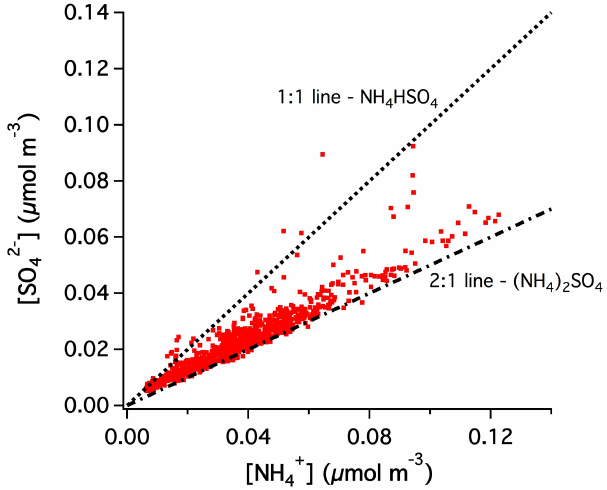
Figure 2. Correlation of SO 2 − by MARGA during the 2013 SOAS campaign (1 June to 13 July). The higher concentrations of SO 2 − environment at the SOAS site, with insufficient moles of NH + present to fully balance existing SO 2 −